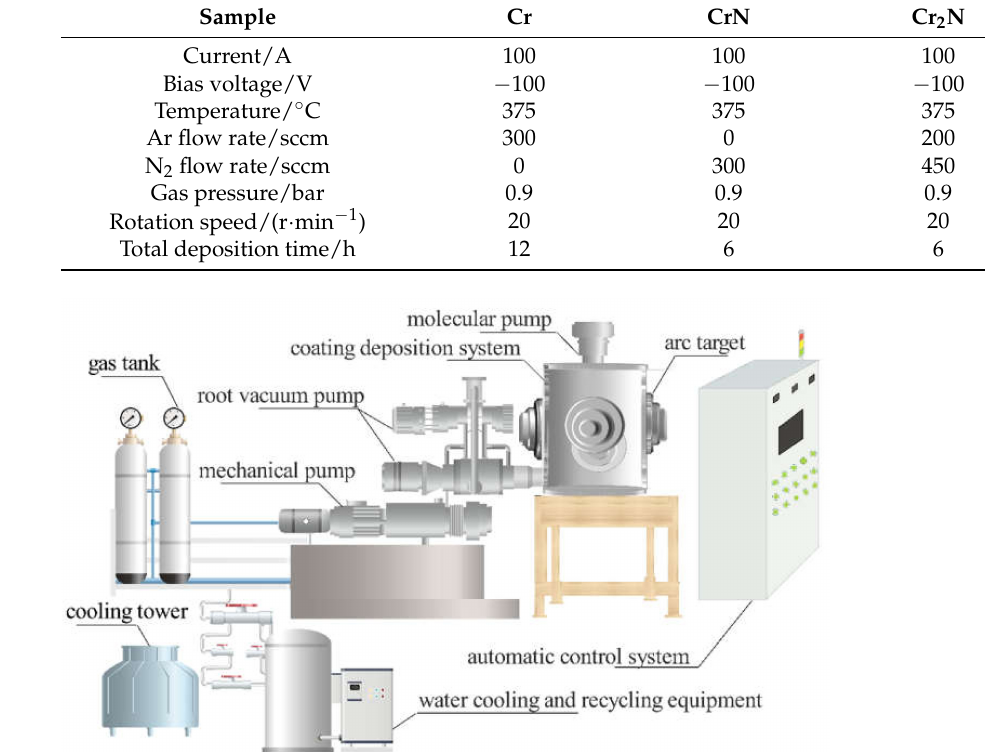
Figure 1. Schematic diagram of the multi-arc ion plating.